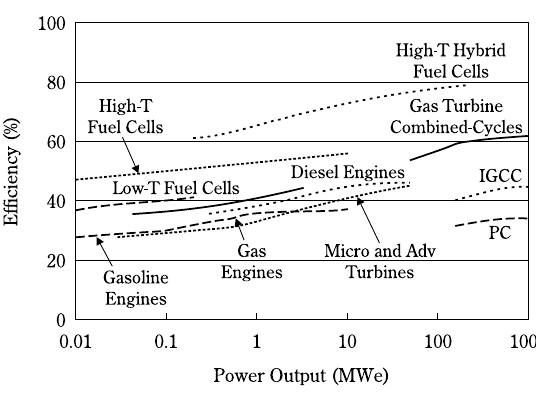
Fig. 5 Thermal efficiencies of power plants Source: